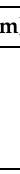
Table 3. FWHM measurements on experimental PSF and the Gibson and Lanni model after estimating t s with the MIDIV, ML and LSQR